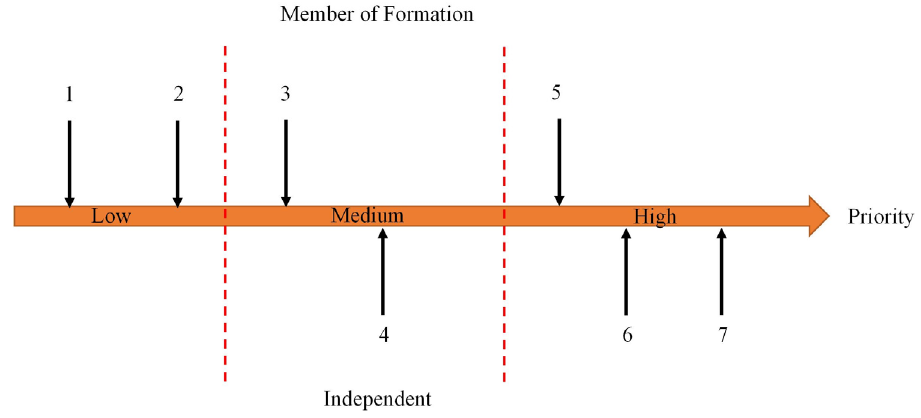
Figure 6. Priority of